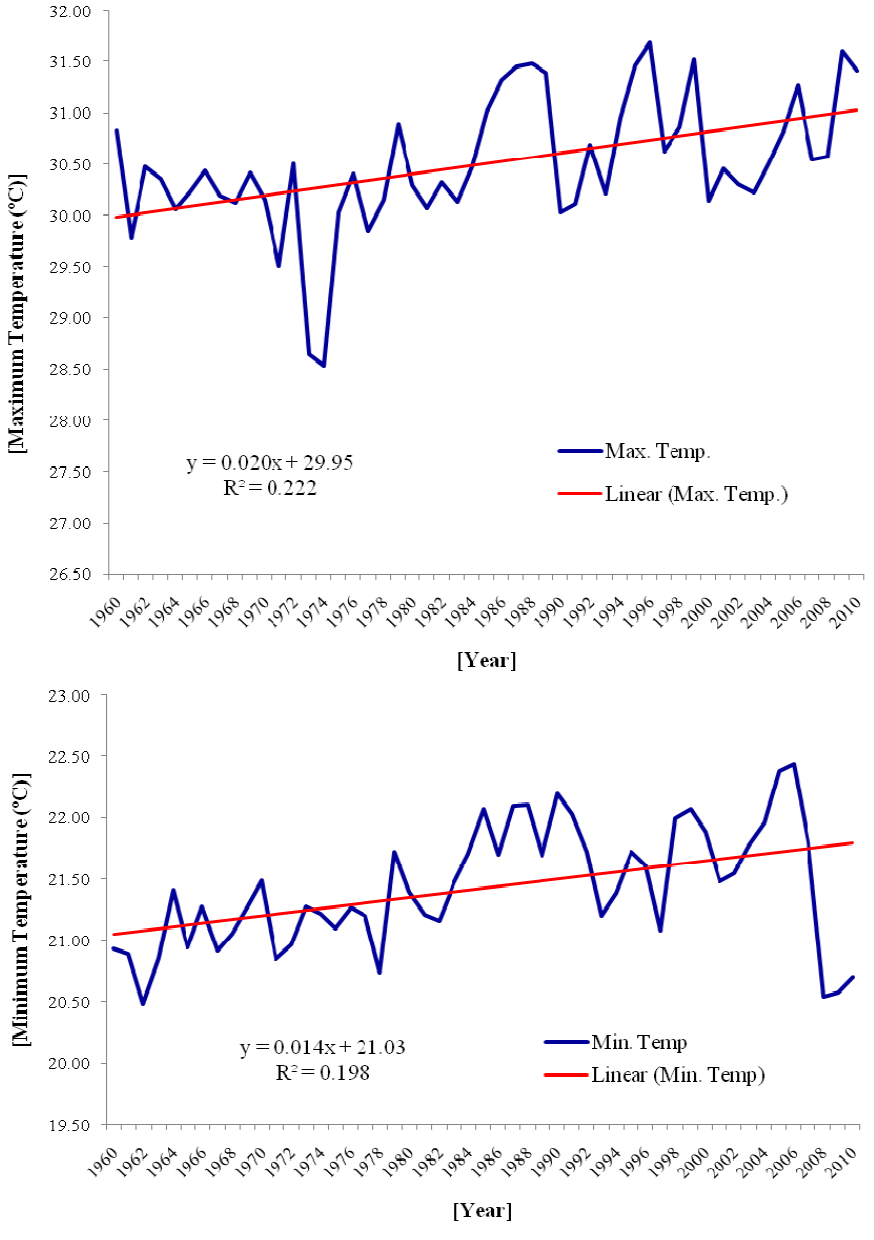
Figure 2. Annual mean temperature ( minimum and maximum ) of Dhaka